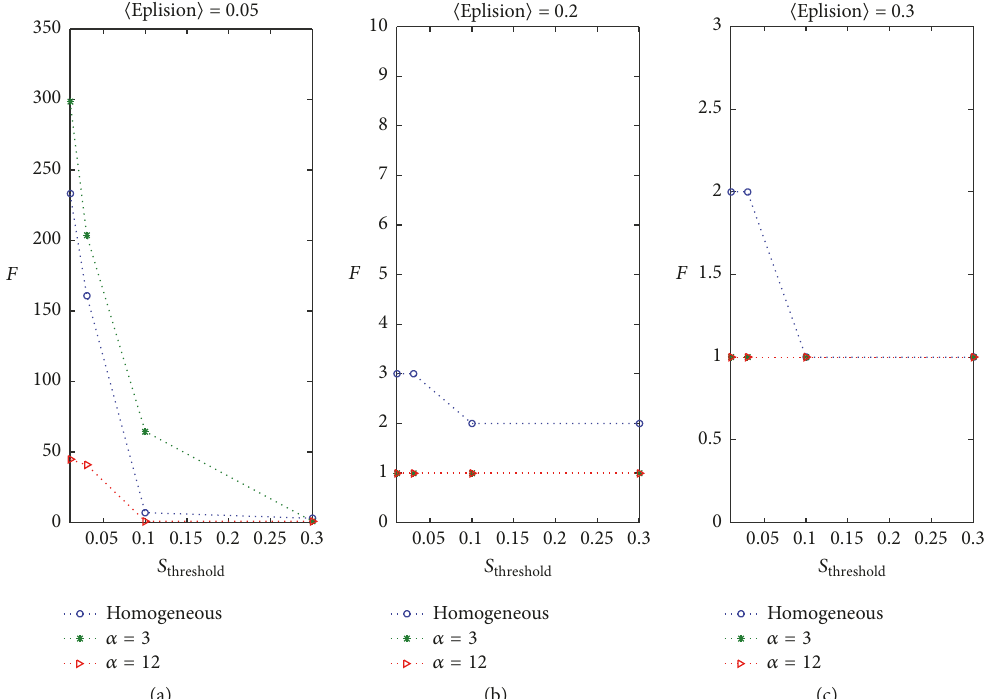
Figure 9: Comparison of 𝐹 (opinion cluster number) on the heterogeneous SSHK model and homogeneous SSHK model with the negative correlation between the confidence bound and social similarity threshold. Every result is averaged 100 times.